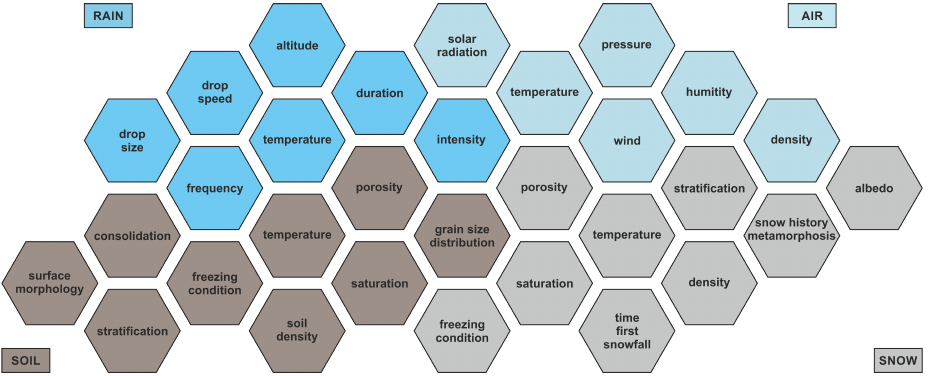
Figure 2. Compilation of varying conditions and properties of rain, snow, soil, and air affecting possible responses of the dynamic